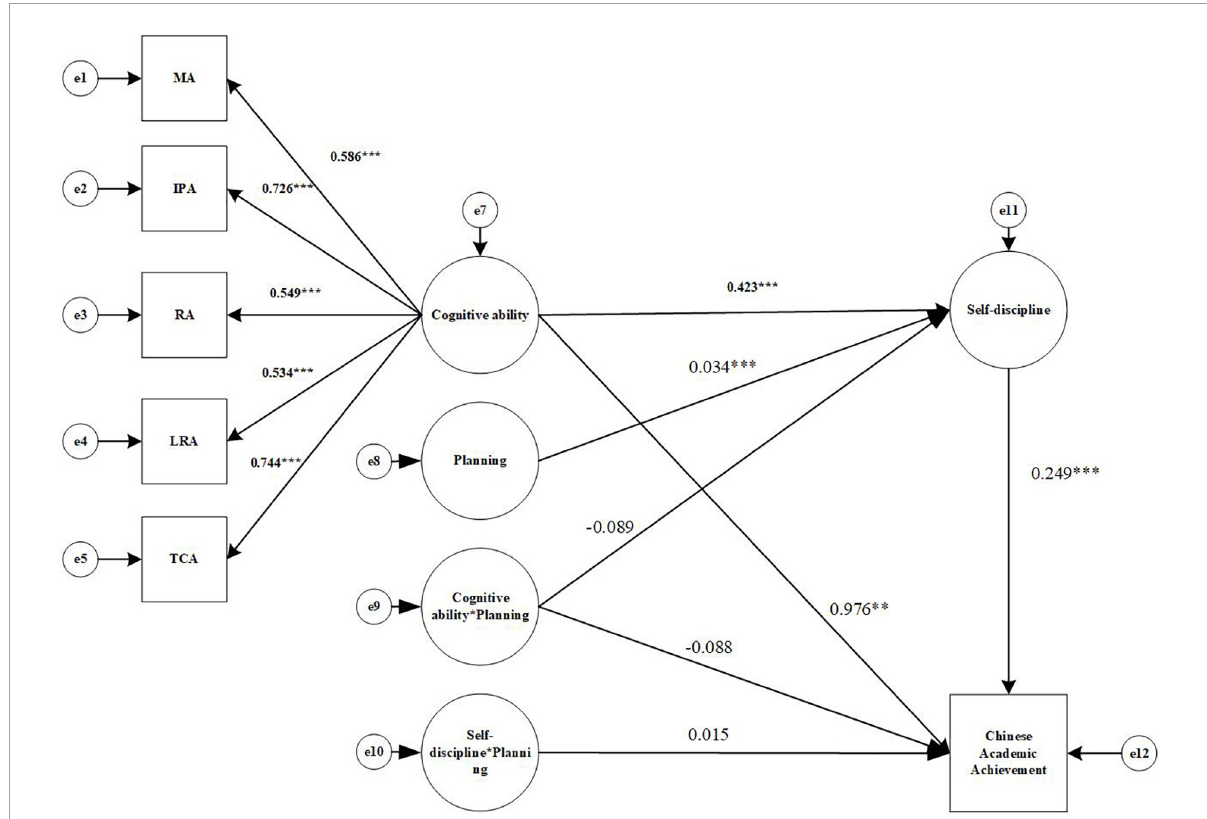
FIGURE4 Structural equation modeling results diagram (Chinese Academic Achievement). MA, Memory ability; IPA, Information processing ability; RA, Representation ability; LRA, Logical reasoning ability; TCA, Thinking conversion ability. ∗ p < 0.05, ∗∗ p < 0.01, ∗∗∗ p <